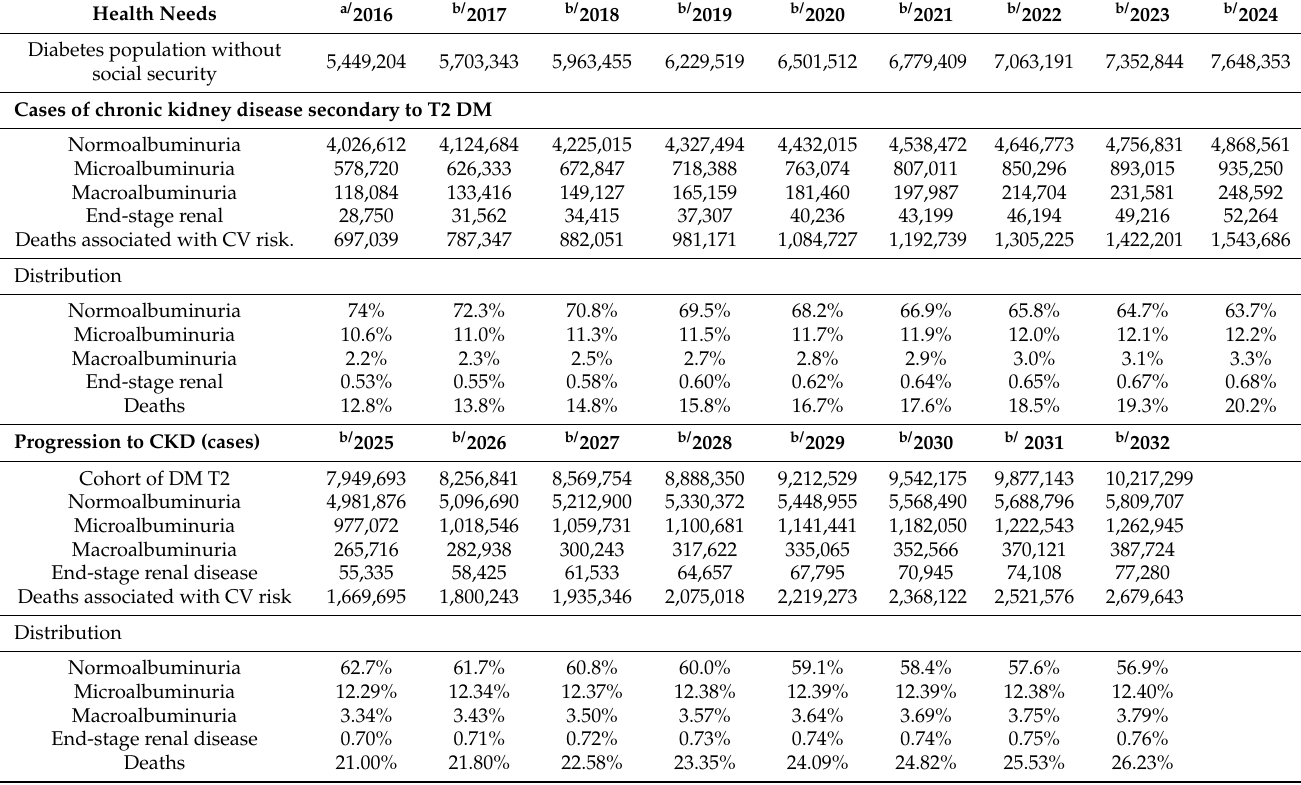
Table 3. Health needs assessment of CKD secondary to T2 DM in patients without social security in Mexico (20–79 years of